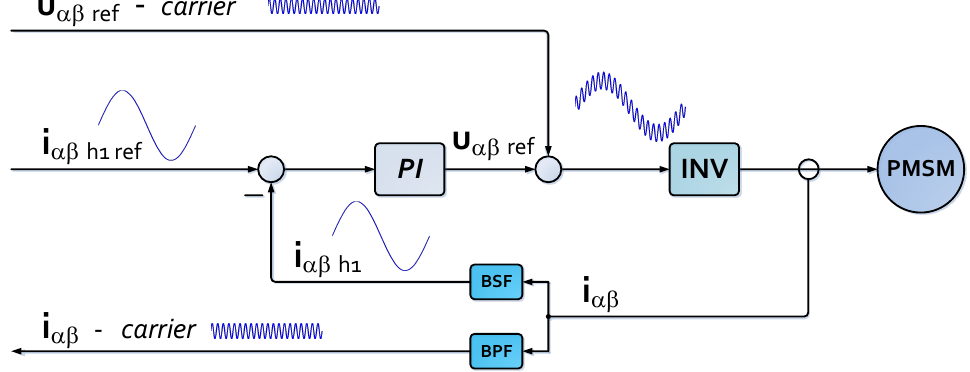
Figure 1. General view of the injecting carrier signal excitation scheme for sensorless PMSM as the quasi 2-dimensional αβ control